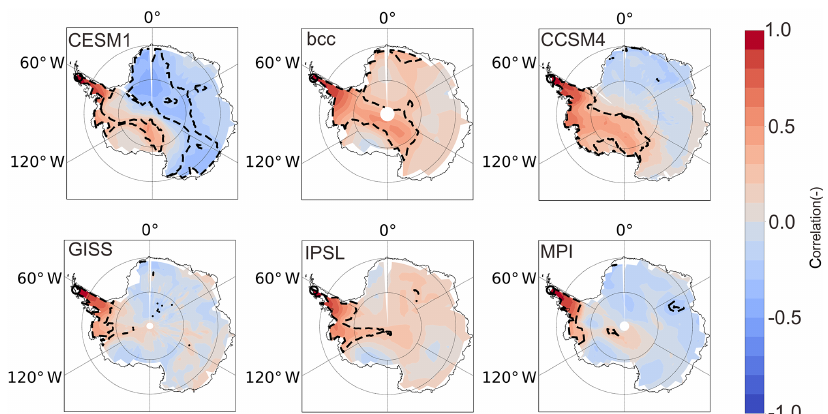
Figure 8. The correlation map (blue to red shaded area) showing the relationship between the temperature from 1825 to 1925CE at Larissa and other grid cells in Antarctica for each climate model. The dashed black contour lines show a significant correlation at the 99% significance level.